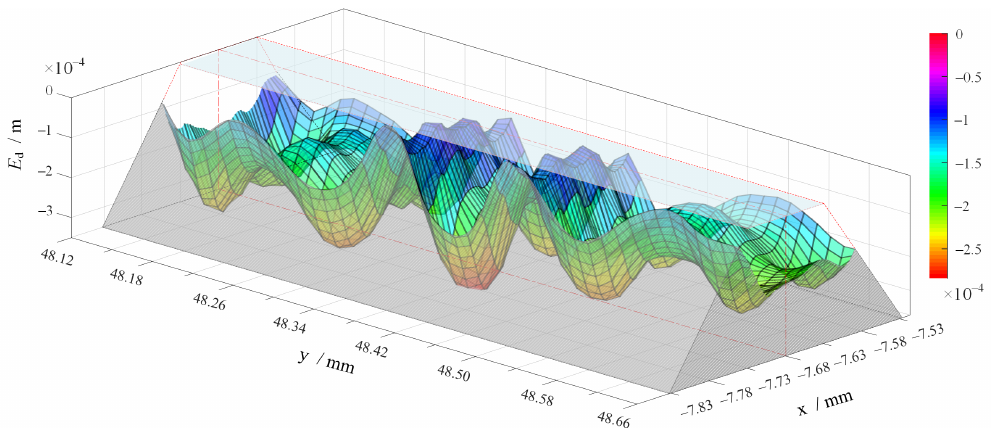
Figure 22. Erosion depth distribution after 1000h for oil of NAS